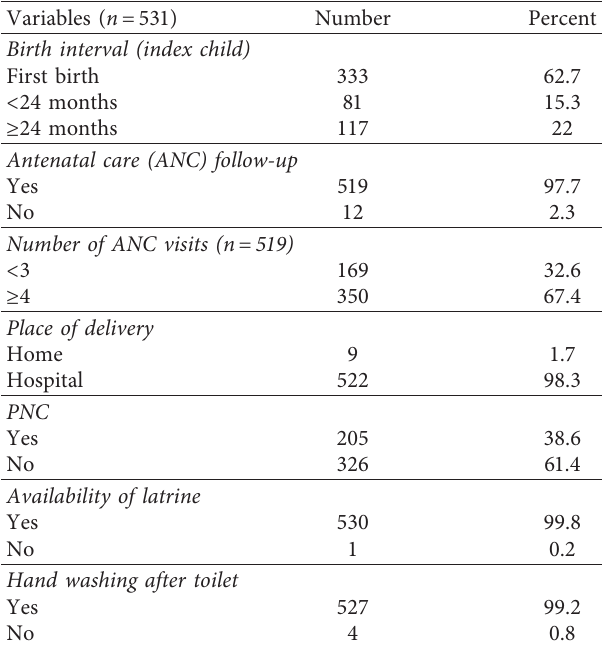
Table 3: Health care and environmental health-related charac- teristics of mothers or caregivers in Debre Berhan Town, North Showa, Zone, Ethiopia, 2018.